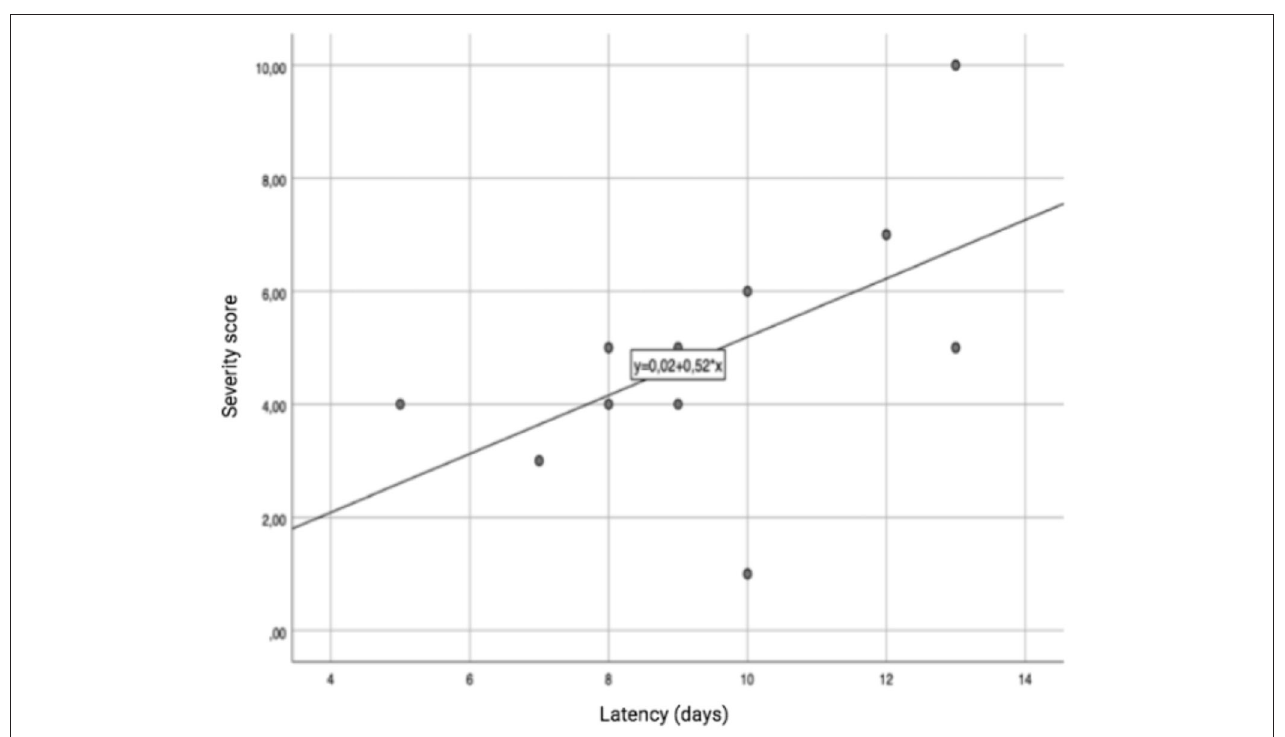
FIGURE 4 | Correlation between the latency time since the last administration of MTX and the severity of the clinical